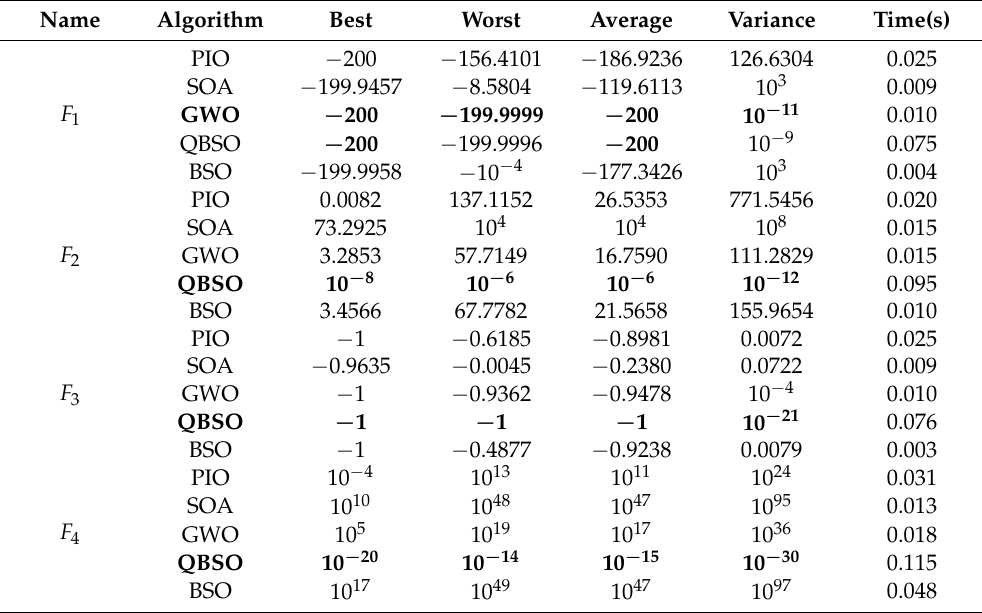
Table 3. Results of the unimodal benchmark function experiments (population size =